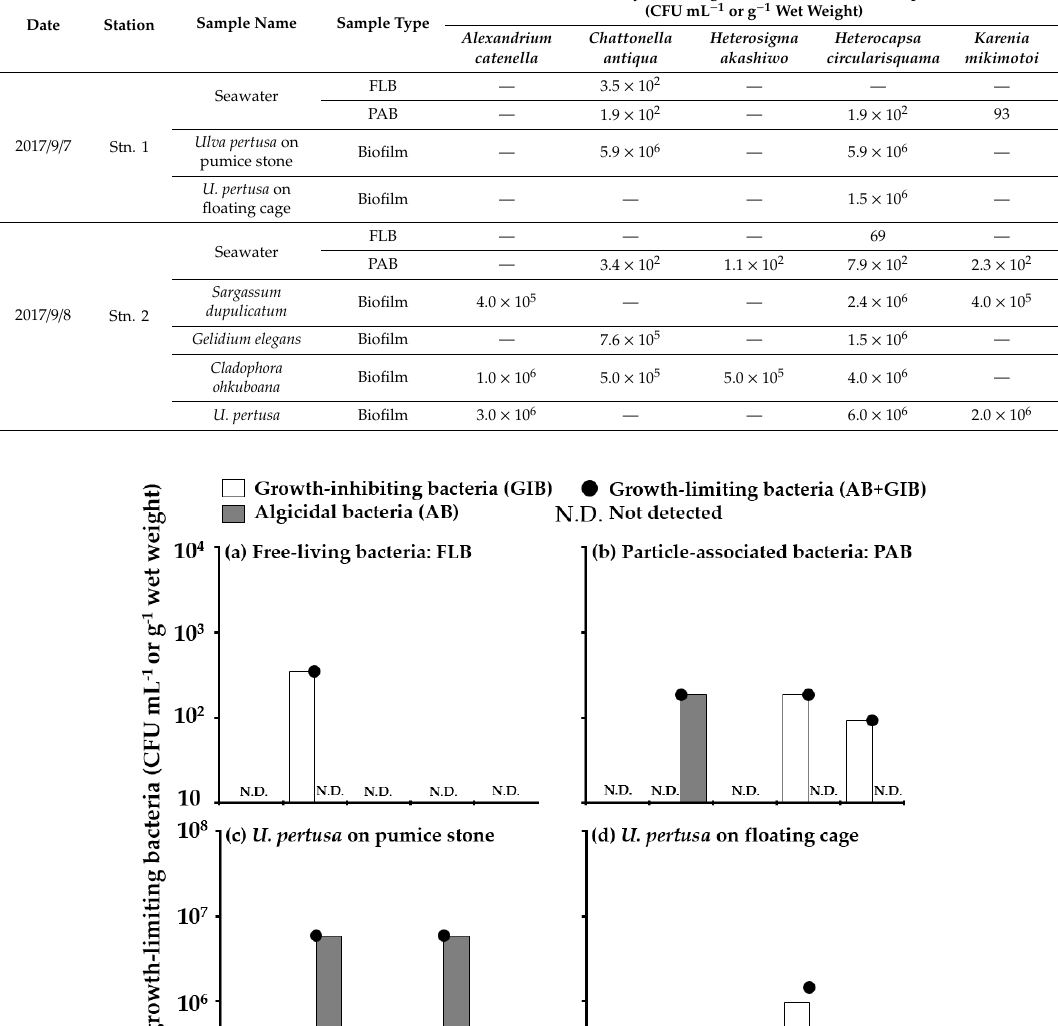
Table 2. Summary of growth-limiting bacteria (GLB) densities against five different harmful algal bloom (HAB) species estimated through co-culture experiments from seawater and macroalgal biofilms at Stns. 1 and 2.